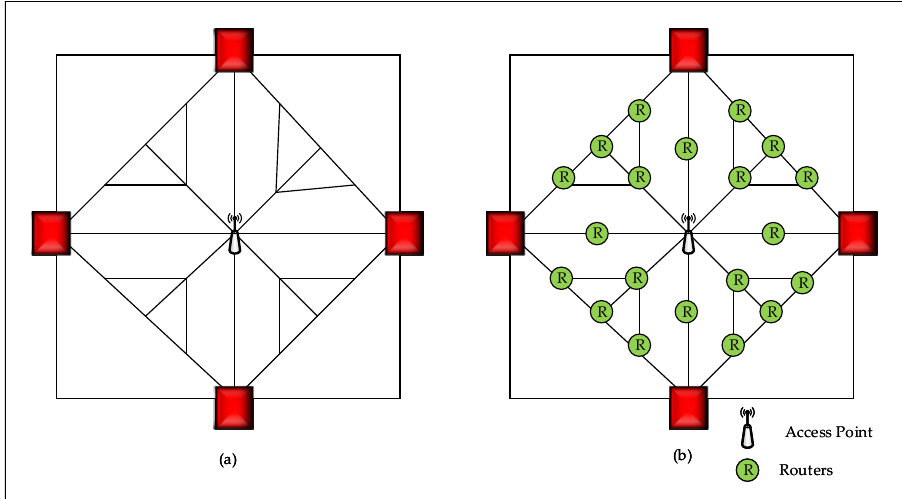
Figure 4. ( a ) Phase 2: place access point, ( b ) Phase 3: plan routes and place the